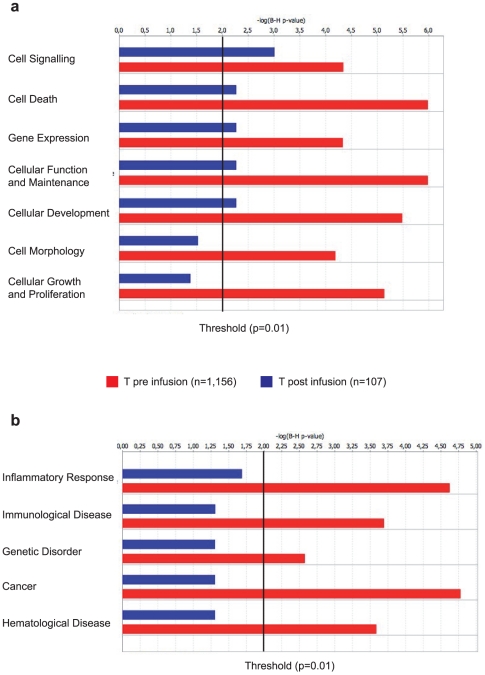
Functional classification of genes targeted by integration clusters.The figure shows those function (a) and disease (b) categories significantly over-represented among the target genes of MLV integration clusters in pre-infusion (red bars) or post-infusion (blue bars) T cells, as analyzed by the Ingenuity® software, using the Ingenuity Pathways Knowledge Base gene population as background. P values were corrected for multiple testing by the Bonferroni method. Statistical significance was set at a p-value of 0.01 (2 in log scale, vertical line). (n) represents the total number of genes eligible for the analysis.